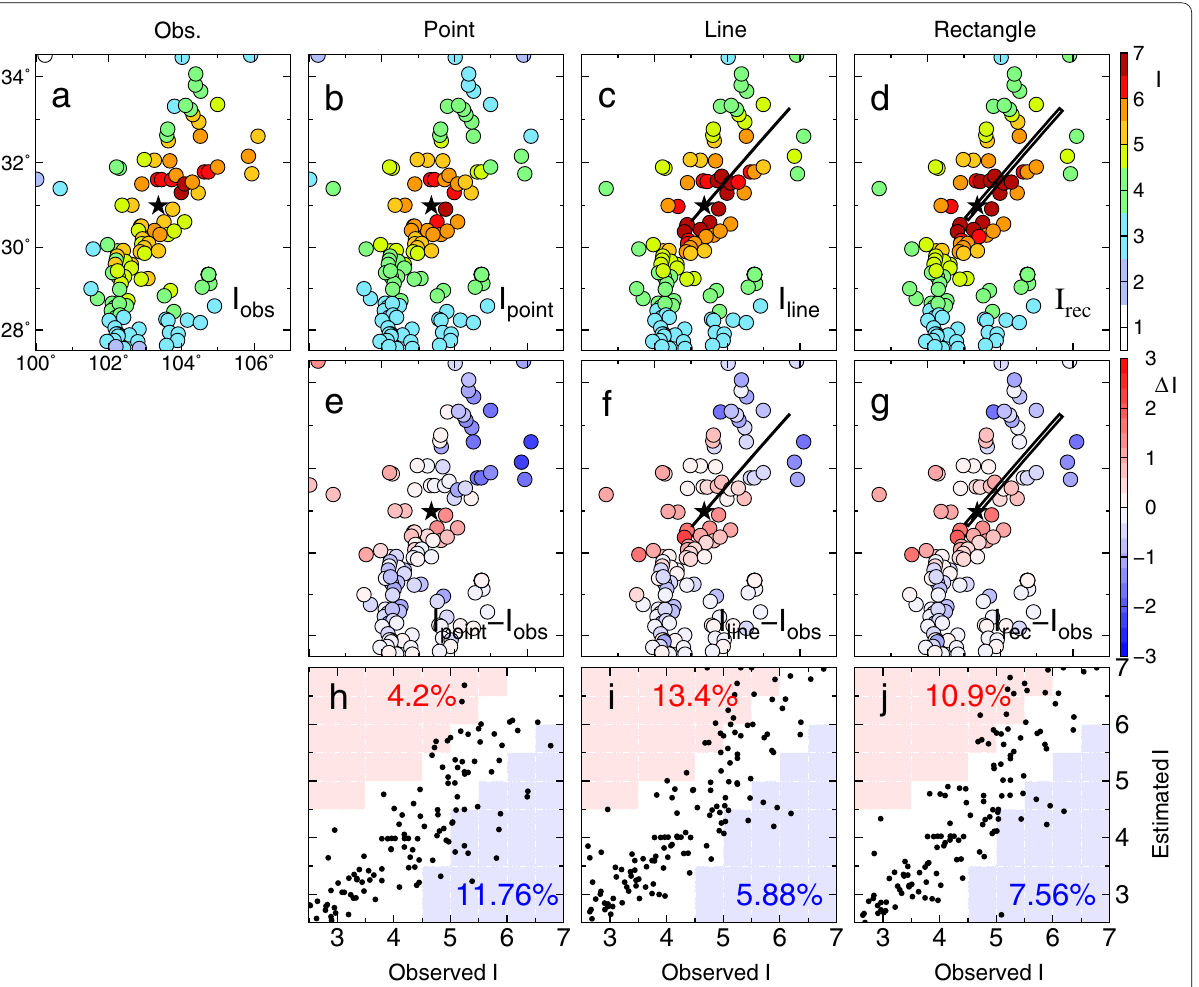
Fig. 10 Distribution of the seismic intensity and its error at 125 s for the 2008 Wenchuan earthquake. The format is the same as in Fig.